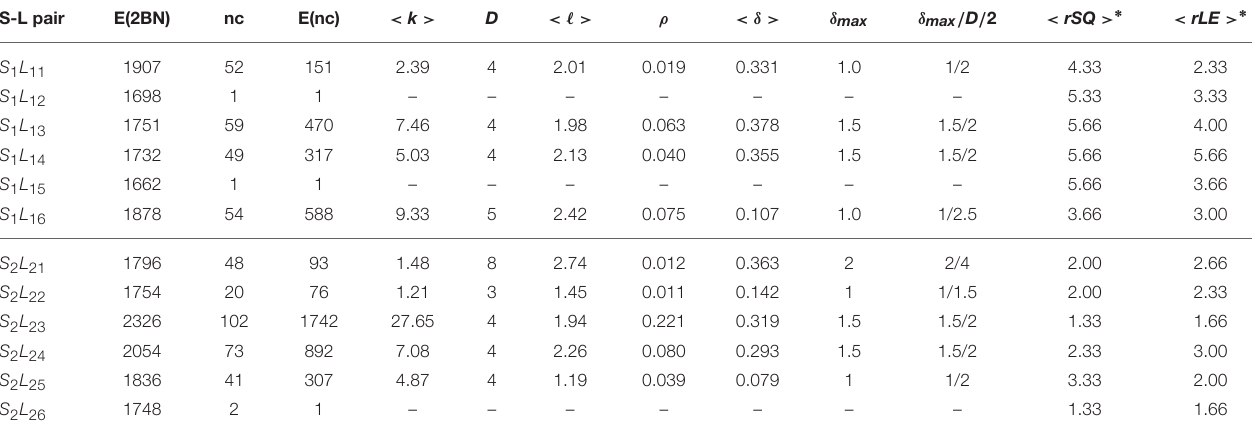
TABLE A1 | Properties of the subgraphs formed by the cross-brain connector nodes, cf. Figure 8 , in different Speaker-Listener pairs in group one (top part) and group two (lower part).